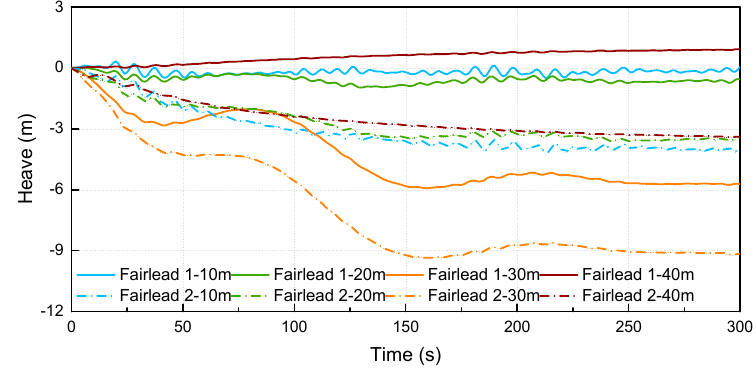
ff erent submerged